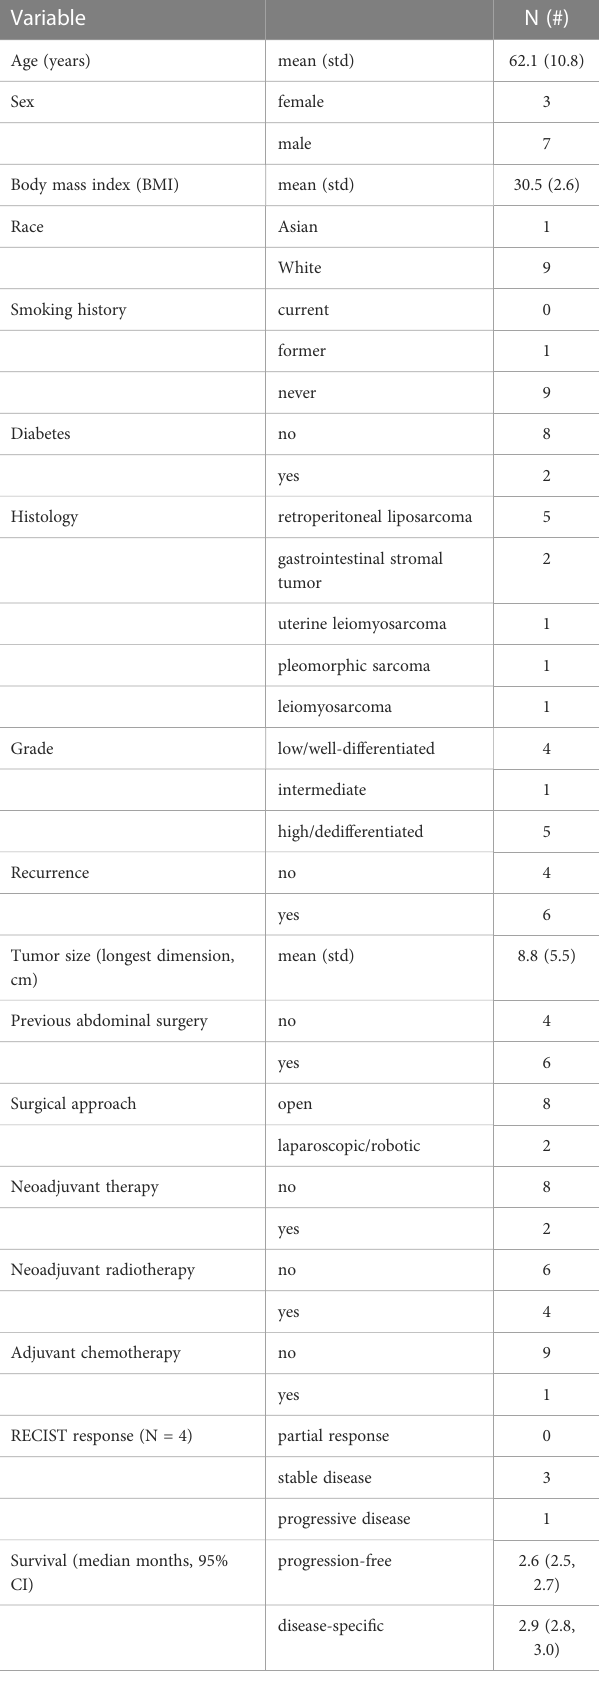
TABLE 1 Patient, tumor, and treatment-related